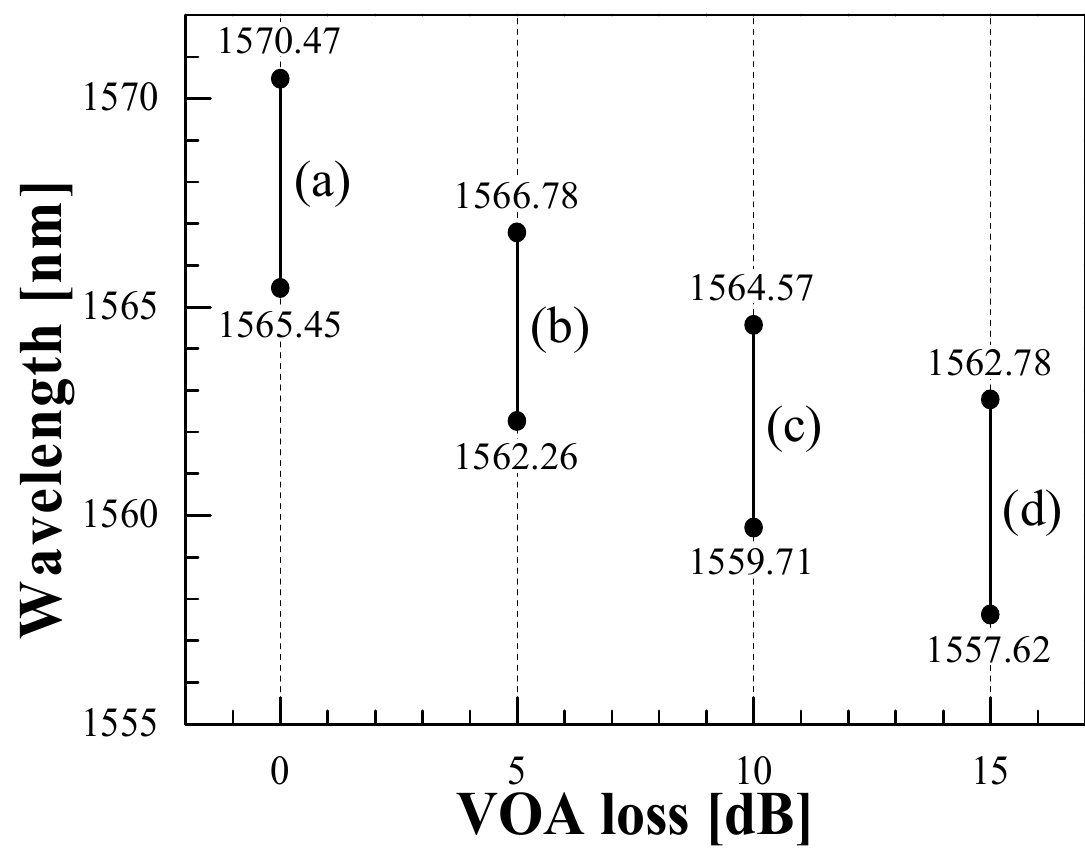
Figure 5. Range of single-wavelength operation for different VOA losses: ( a ) 0 dB, ( b ) 5 dB, ( c ) 10 dB, and ( d ) 15 dB.